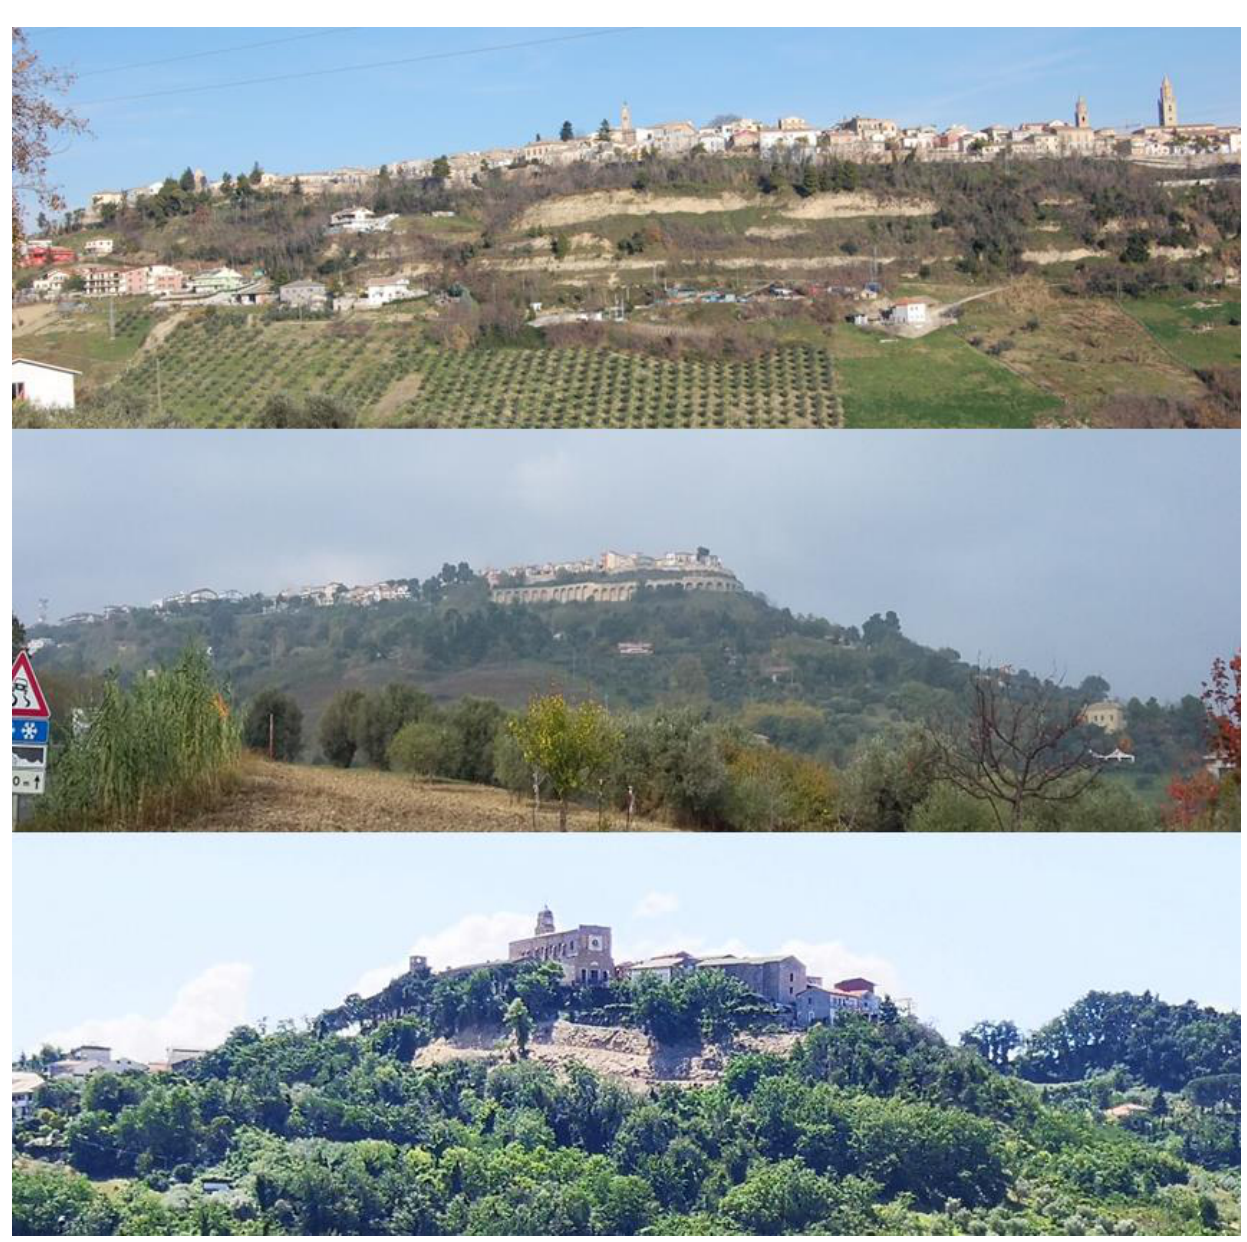
Figure 2. Examples of historical centers located on the arenaceous plain. At the top, Atri; in the middle, Silvi; at the bottom, Miglianico (see Figure 1 for the locations).